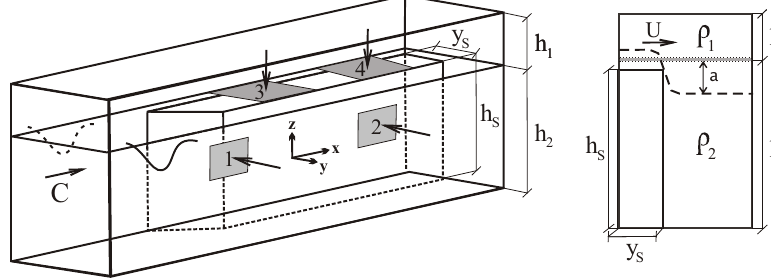
Fig. 10. Sketch of the experimental facility (numbers at the left figure denote positions of video-cameras).